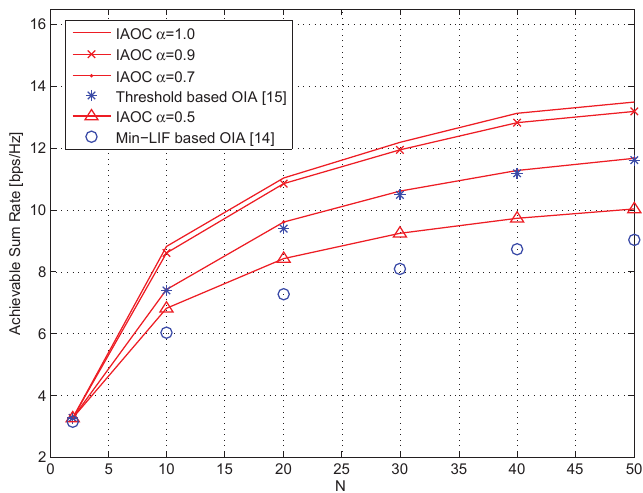
Figure 5. The achievable sum rate versus N . K = 4, N r = 4, N t = 2, S = 2.